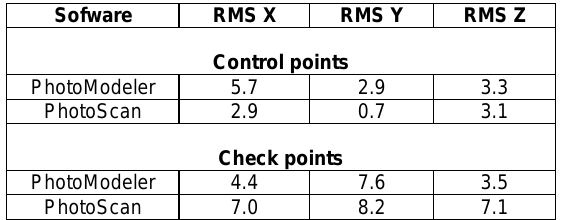
Table 5. RMS values (mm) on control and check points for the closed